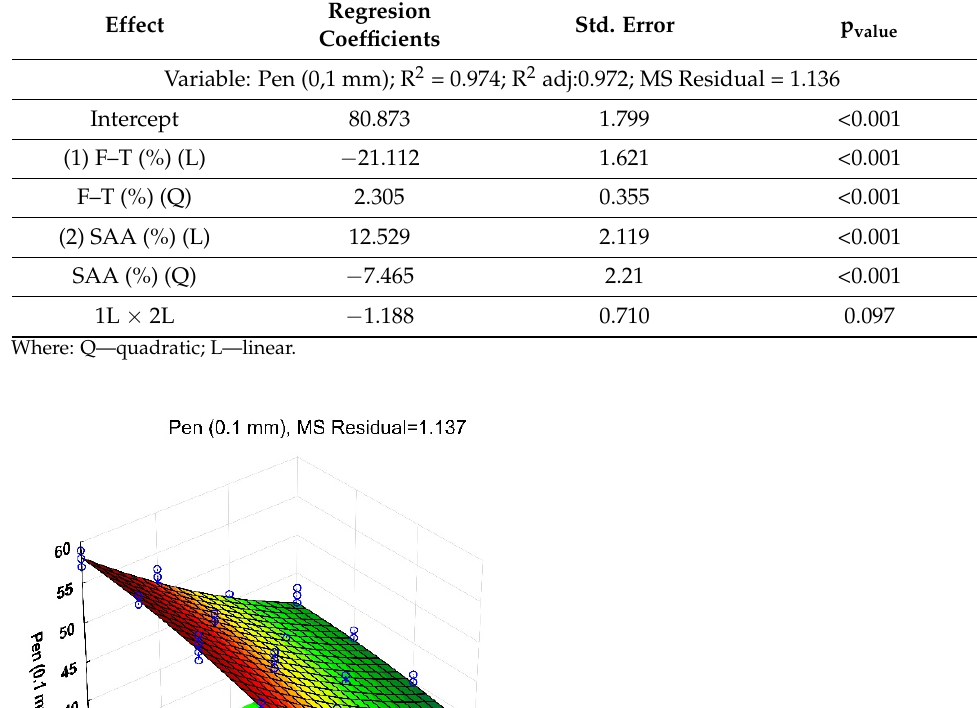
Table 4. Evaluation of the significance (ANOVA) of the factorial impact (F–T wax and SAA) on Pen.